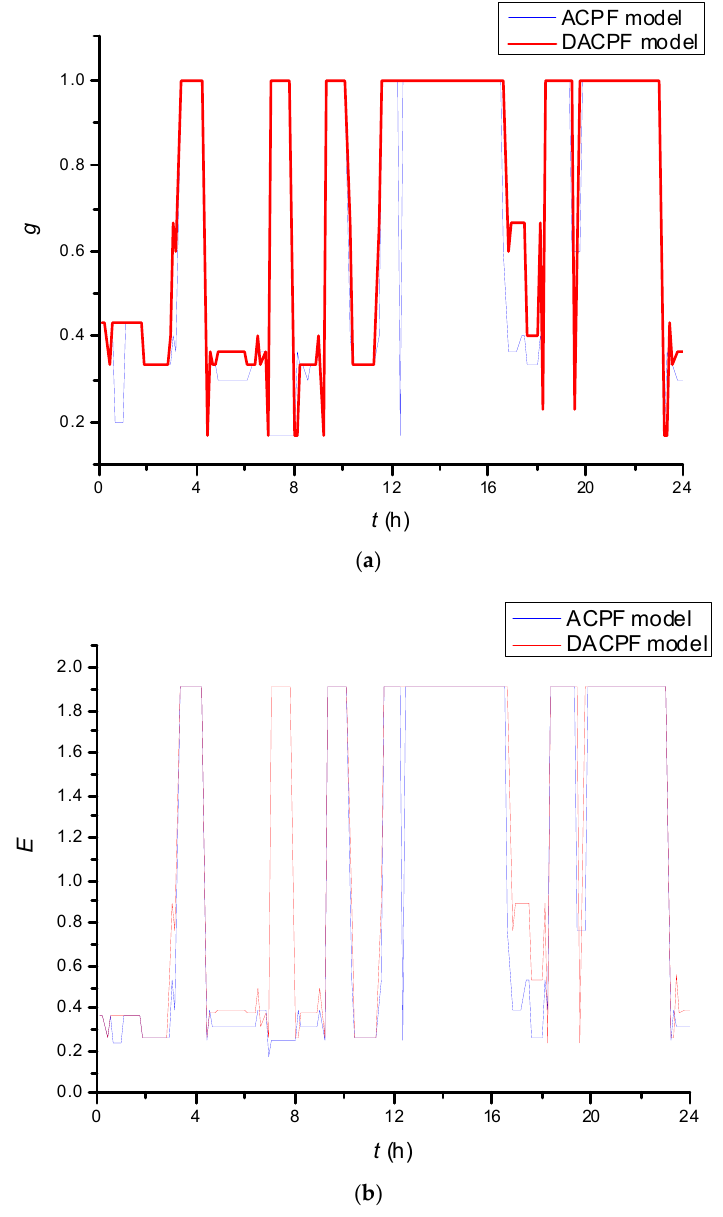
Figure 6. Comparative analysis of the impacts of wind power, ( a ) Connectivity; ( b ) Global effective performance.